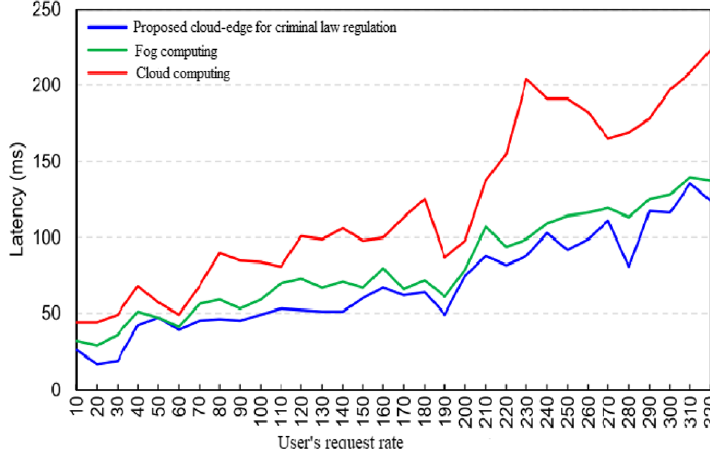
Fig. 11 Average system utilization time per user request